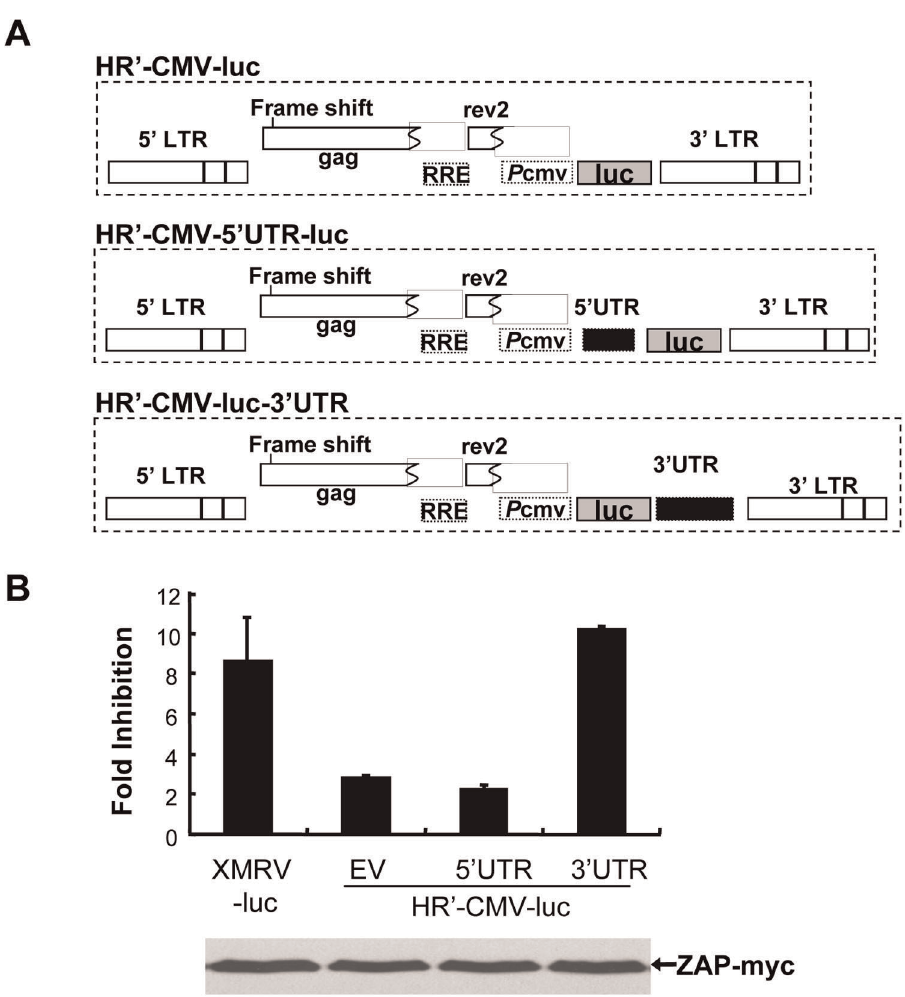
Figure 5. ZAP targets the 3 9 LTR of XMRV. (A) Schematic structures of HR’-CMV-luc vectors. (B) 293TRex-hZAP-v2 cells were infected with the vectors indicated. At 3 h postinfection, cells were mock treated or treated with 1 m g/ml tetracycline to induce ZAP expression. At 48 h postinfection the cells were lysed and luciferase activity was measured. Fold inhibition was calculated as luciferase activity in mock treated cells divided by luciferase activity in tetracycline treated cells (up panel). Data presented are means 6 SD of three independent experiments. The expression of hZAP- v2 was confirmed by Western blotting (lower panel).